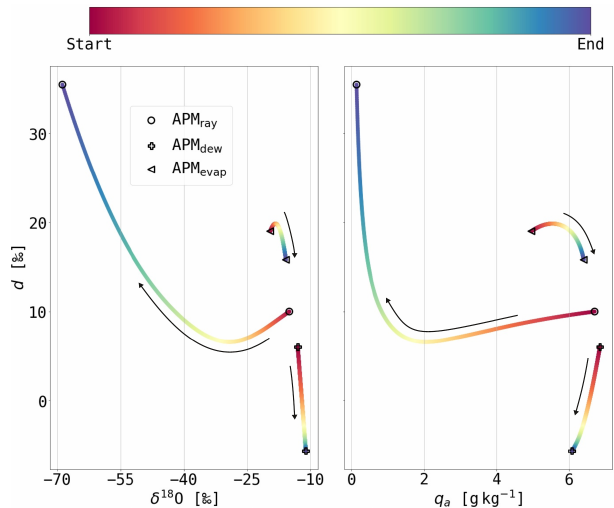
Figure 2. Phase space diagrams of (a) d versus δ 18 O and (b) d versus q a for the example simulations with APM evap ( ), APM dew ( + ) and APM ray ( ◦ ) discussed in Sect. 3.1, 3.2 and 3.3. The lines are coloured from the start to the end position. The black arrows show the direction from the start to the end during the